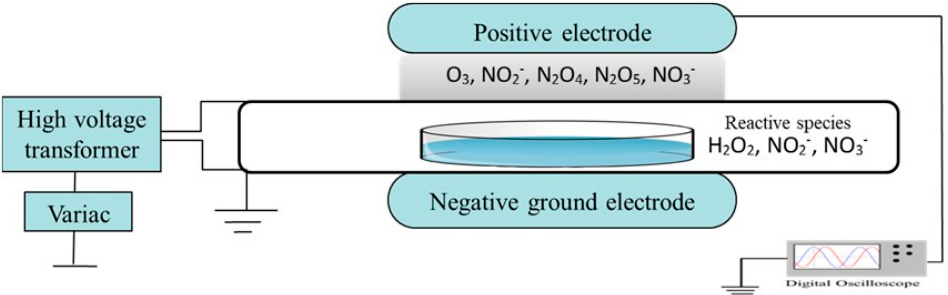
Figure 1. Schematic of the experimental setup of the dielectric barrier discharge plasma generator.